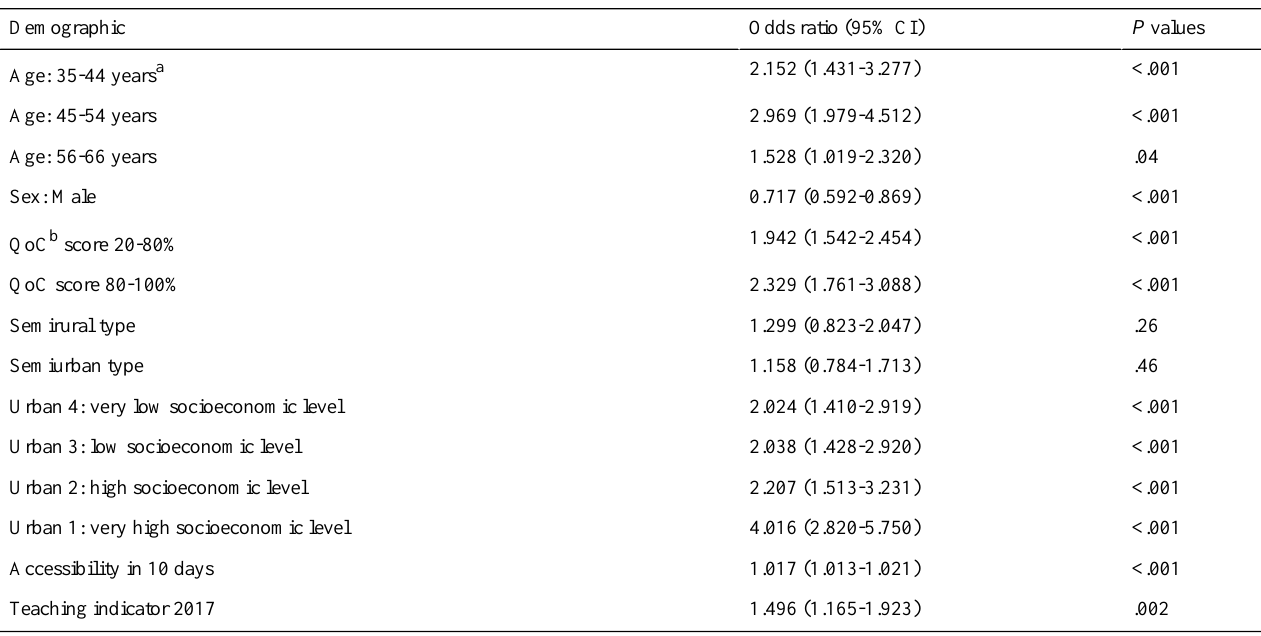
P valuesOdds ratio (95%